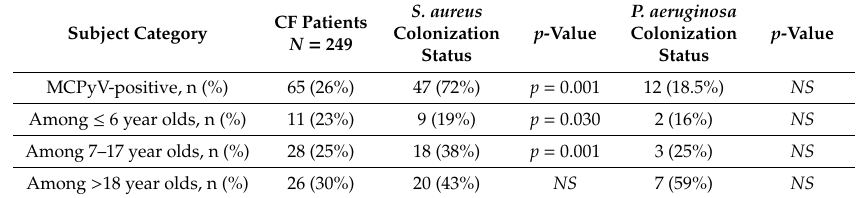
Table 2. MCPyV, Staphylococcus aureus , and Pseudomonas aeruginosa colonization status in CF patients.